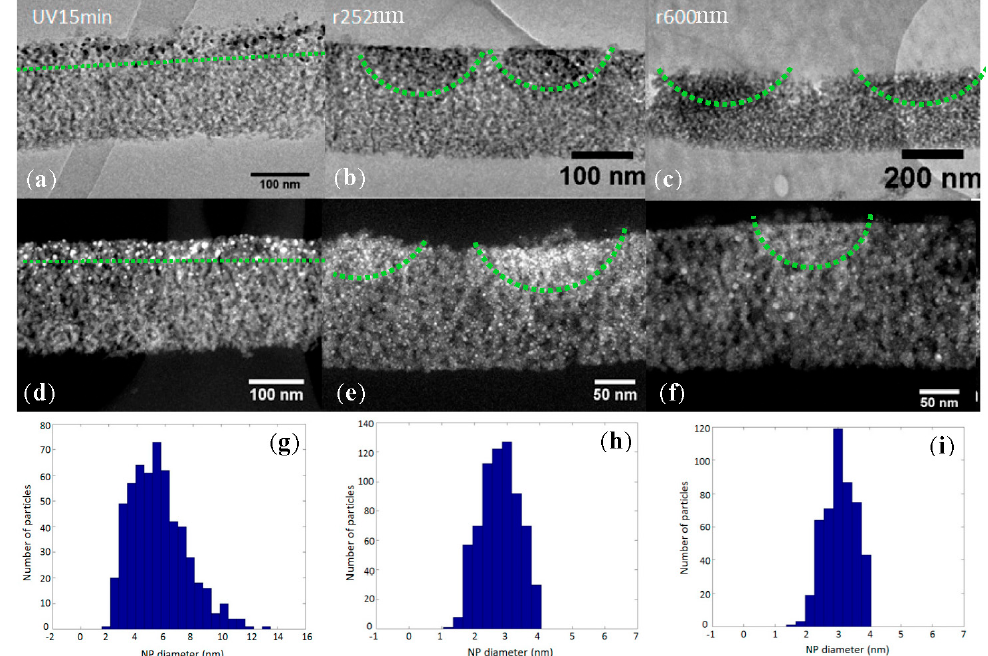
Figure 1. Transmission electron microscopy (TEM) ( a–c ) and high-angle annular dark field scanning transmission electron microscopy (HAADF-STEM) ( d – f ) images of cross-section of samples UV15min ( a , d ), r252nm ( b , c ) and r600nm ( e , f ). Nanoparticle (NP)-size histograms deduced from image processing carried out on the HAADF-STEM images of samples UV15min ( g ), r252nm ( h ) and r600nm ( i